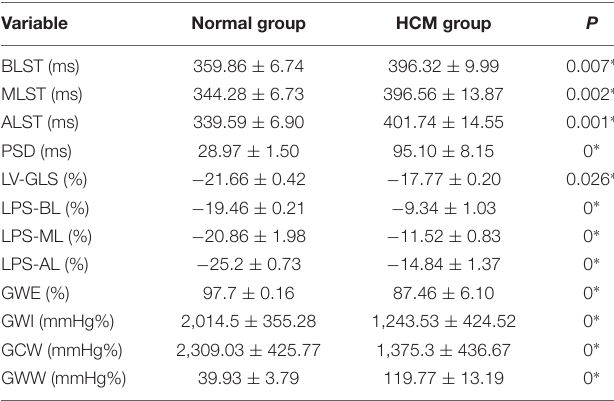
TABLE 2 | Comparison of myocardial work and strain between normal group and HCM